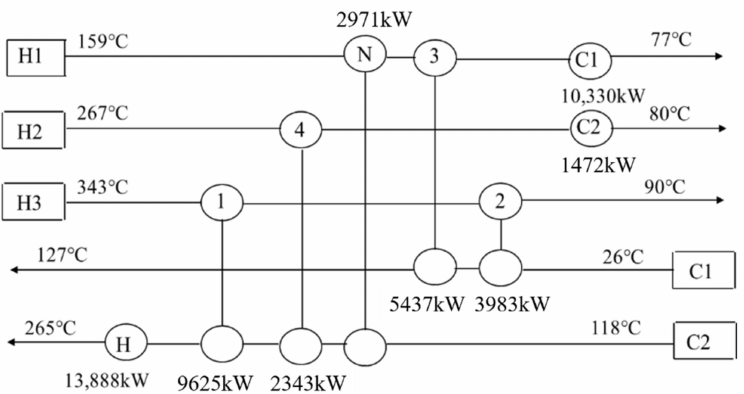
Figure 10. Adding a new shell-and-tube heat exchanger for case study